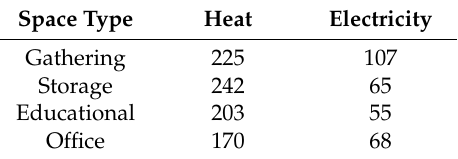
Table 4. Average energy consumption values in various spaces in Finland (kWh/m 2 /a) according to [31]. Space